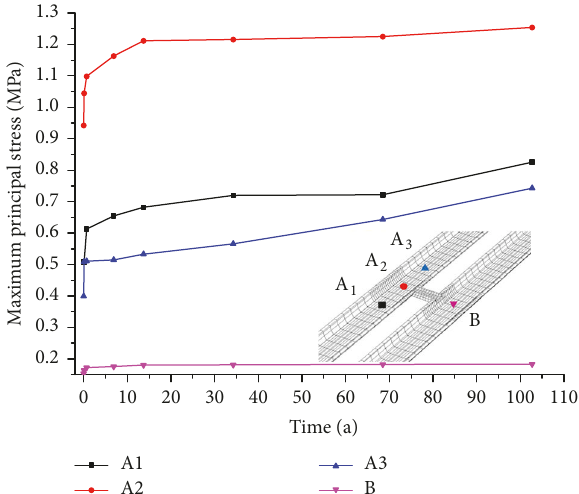
Figure 10: Time-history curve of maximum principal stress (A2).